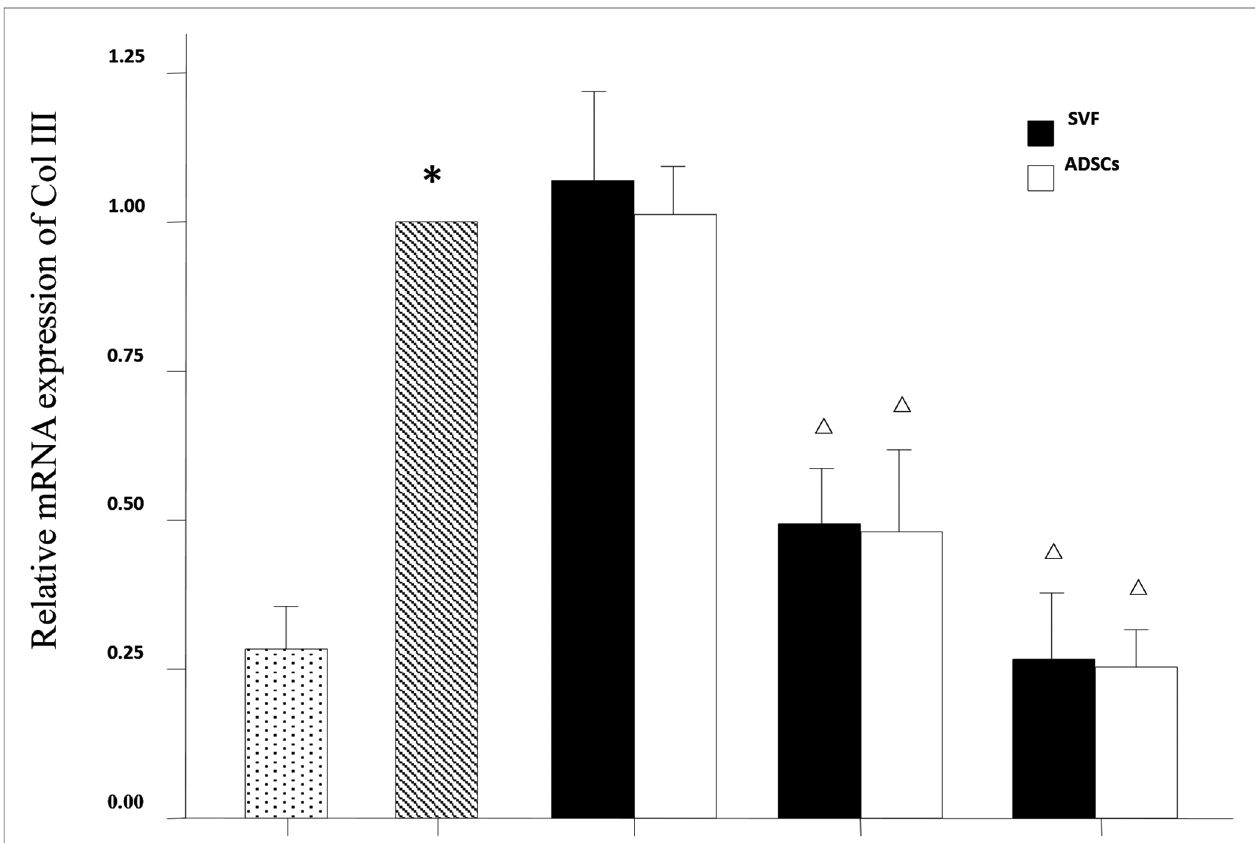
FIGURE 7 | qPCR showed the relative mRNA expression of collagen III of nude rats exposed to UVB 28 days after SVF and ADSCs treatment. Mean±SD. n =6. * P <0.05 vs control group. △ P <0.05 vs UVB model